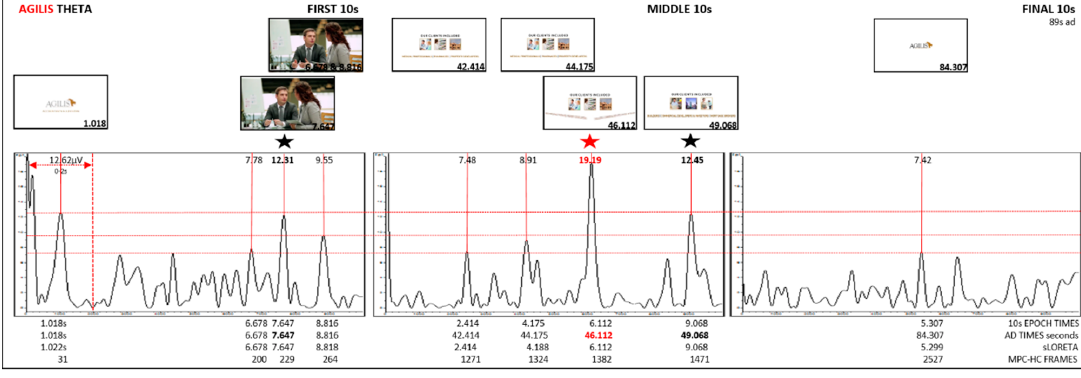
Figure 4. Agilis grand average theta from first, middle, and final 10-s epochs.